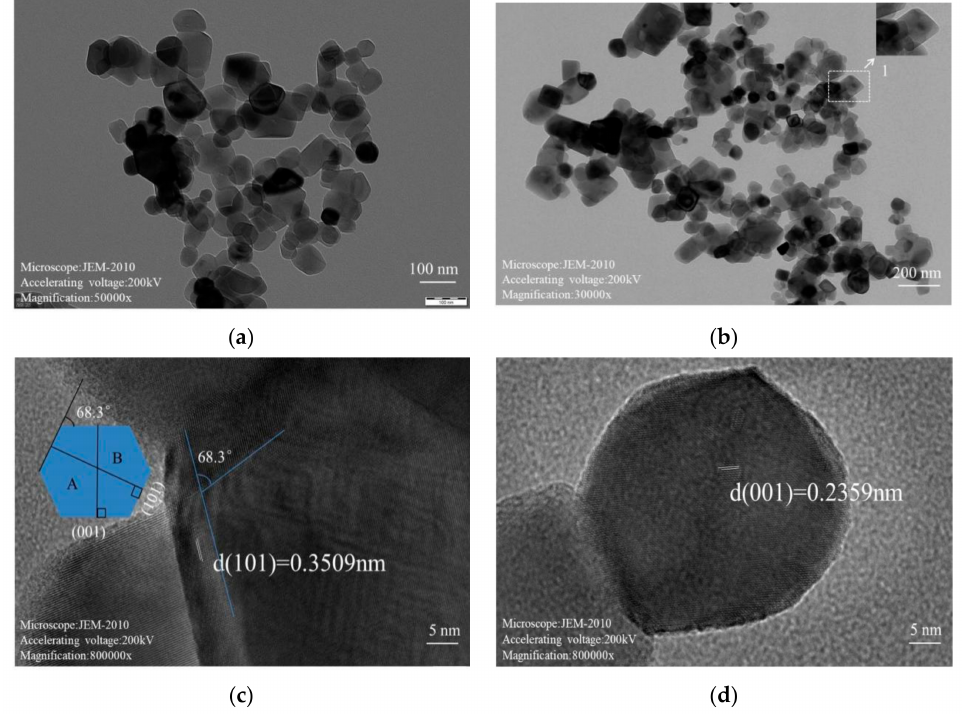
Figure 2. TEM images of pure TiO 2 : ( a ): Sample Magnified 50,000 × , ( b ): Sample Magnified 30,000 × , ( c ): (101) Crystal plane spacing, and ( d ): (001) Crystal plane